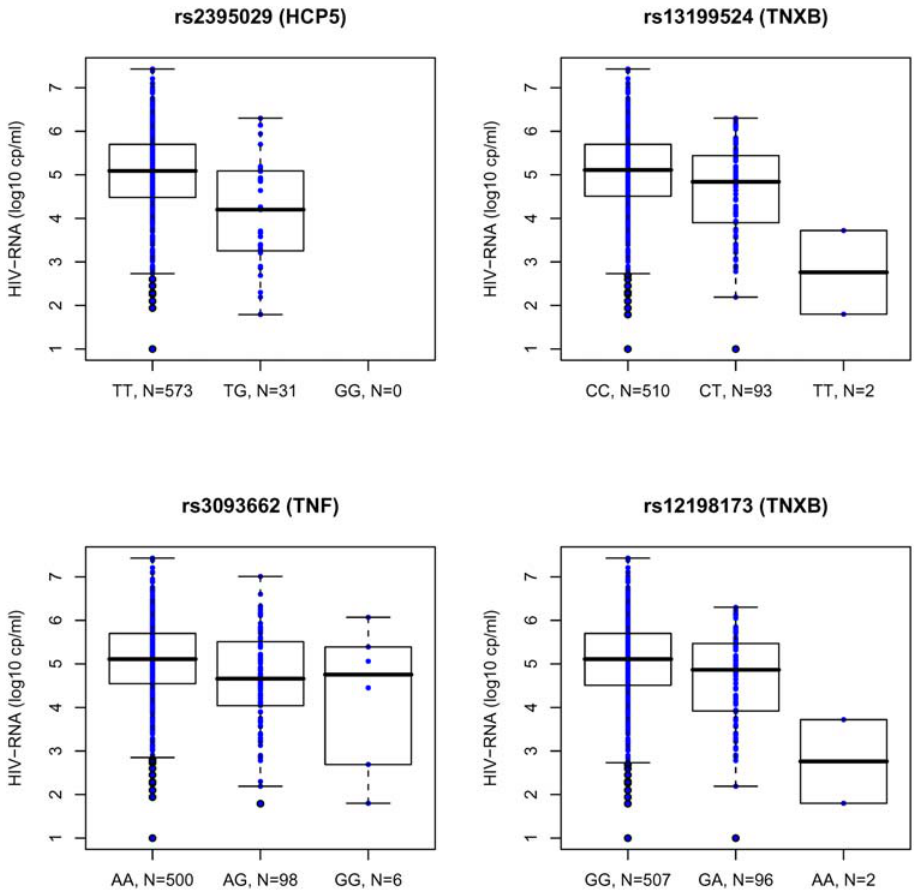
Figure 3. Boxplots for HIV-RNA levels in the PRIMO cohort for four major SNPs. Plasma HIV-RNA level is highly correlated with the rs2395029 (HCP5), rs3093662 (TNF), rs13199524 and rs12198173 (TNXB) genotypes.